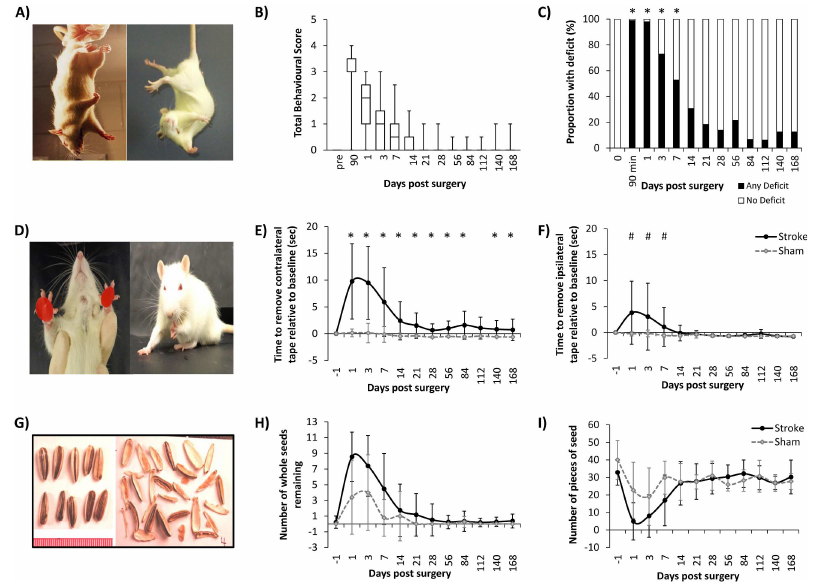
Fig 1. Assessment of behavioural deficit for 6 months afterstroke. BasicBehaviouralTest: A) Forelimb flexionandtorso twisting.B) Total scoreoverthe timecourseof the experiment. C) Presenceof a deficit(shaded) overthe courseof the experiment. Adhesive RemovalTest: D) Placement andremovalof tapeon the forepaws. E) Time to removecontralateral(left) tape relativeto baselineability.F) Time to removeipsilateraltaperelativeto baselineability.Sunflower SeedChallenge: G) Intact andbrokenseeds.H) Numberof wholeseedsremaining.I) Numberof piecesof